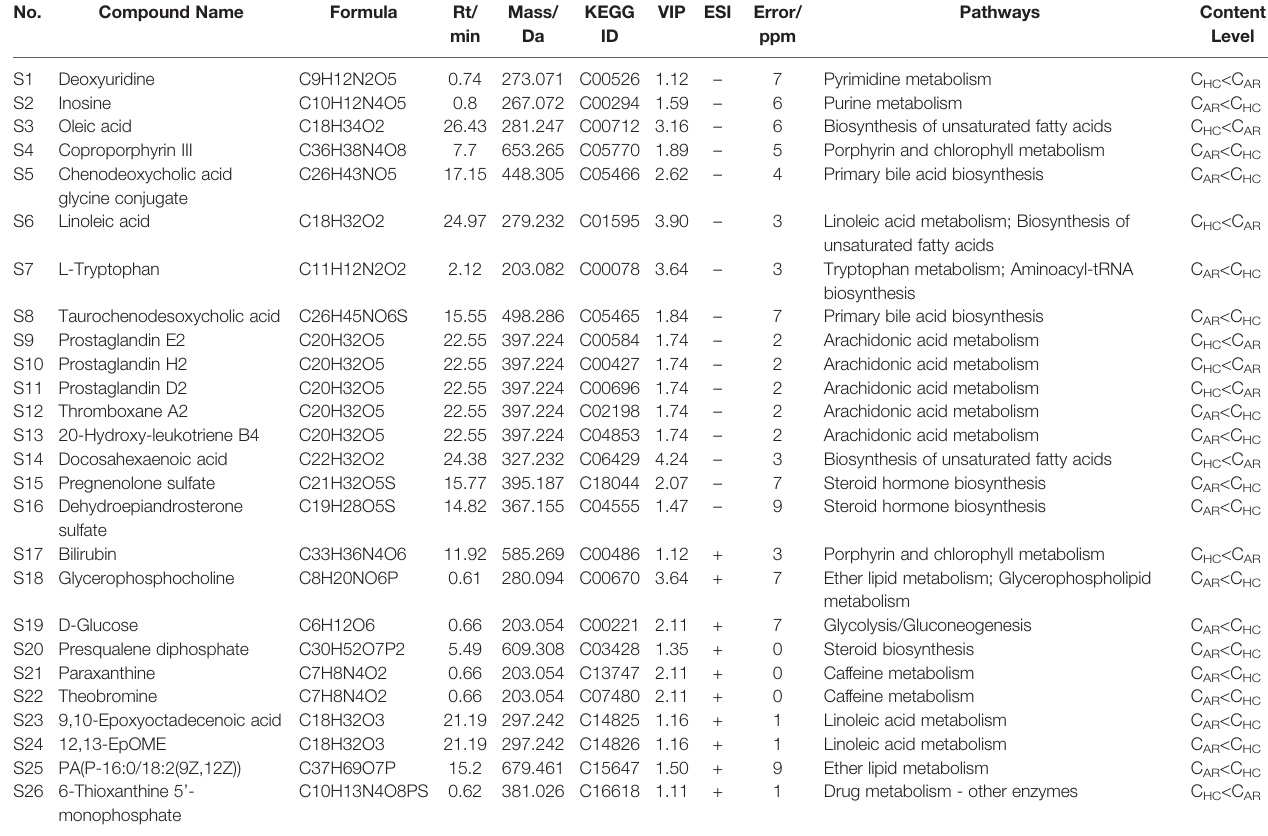
TABLE 2 | Distinct metabolites identi fi ed in serum